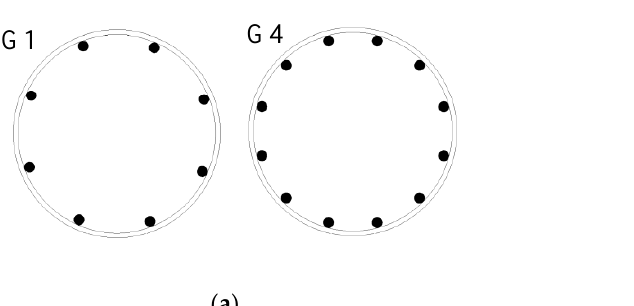
Figure 6. Fabrication of the concrete short columns. ( a ) Positioning of longitudinal bars; ( b ) Before the casting; ( c ) After the casting. 2.3. Test Setup and Procedure Ten strain gauges (S1-S10) were attached to each spiral stirrup from the bottom to the top of the column at intervals of 180° (see Figure 7a). These strain gauges are used to assess the level of shear contribution of the stirrups. Three strain gauges (T1-T3, B1-B3) were attached to the longitudinal bars on the tension and the compression sides of the column to track its deformation. In addition, four concrete strain gauges (C1-C4) were uniformly pasted on the surface of concrete along the anticipated direction of the main diagonal crack, which aims to identify the status and deformation of the concrete. As shown in Figure 7b, four linear variable differential transformers (LVTDs) were installed along the column height direction to monitor the lateral displacement. These strain gauges and LVDTs were connected to a TDS 530 acquisition system to collect corre- sponding data, as shown in Figure 8a. The lead zirconate titanate (PZT) patch is the major component of a smart aggregate (SA). The PZT patch is first embedded in the copper shell and then embedded in the marble [29]. The copper shell serves as shielding protection and the marble functions as mechanical protection and waterproof agent [29]. As shown in Figure 8b, three SA transducers were arranged at the end, middle and top, respectively, of the column to detect damage. Considering that cracks could occur at the bottom end of the column, which could affect the SA monitoring. Therefore, the SA located at the end of the column was bonded on the bottom concrete block. The instrumentation for the SA transducers is presented in Figure 8b. It includes a data acquisition and a power amplifier. A sine sweep signal with an amplitude of 5 V was selected as the excitation signal. Considering that the environmental noise of most structures is generally within 100 Hz, the frequency of sine